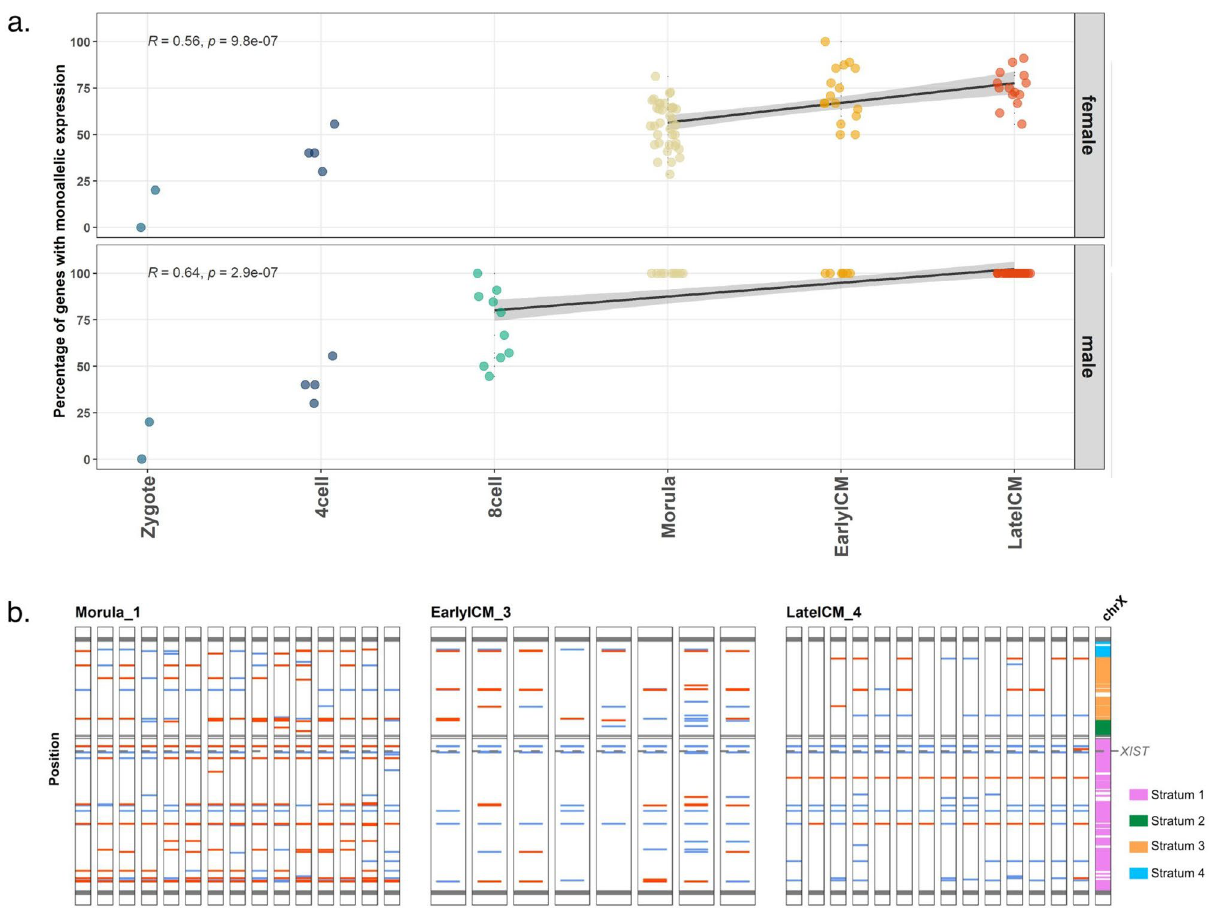
Figure 2. Allelic expression of X-linked genes. ( a ) Percentage of monoallelically expressed X-linked genes for each cell according to embryonic stage. Top panel: female embryos; bottom panel: male embryos. Each dot represents a single cell. Pearson’s r values (R) are depicted in each panel. Gray area indicates a 95% confidence interval. ( b ) Expression patterns of genes along the X-chromosome of female embryos. The color of each position is assigned according to the ratio of allelic expression based on the detected SNP; blue corresponds to monoallelic expression, while red indicates biallelic expression. Each column corresponds to a single cell. The dark grey lines indicate the telomeres; the light gray lines the centromere; and the dashed line corresponds to the putative marmoset XIST locus . ChrX: scheme of the X chromosome showing the evolutionary strata S1, S2, S3 and S4 based on human data 16,17